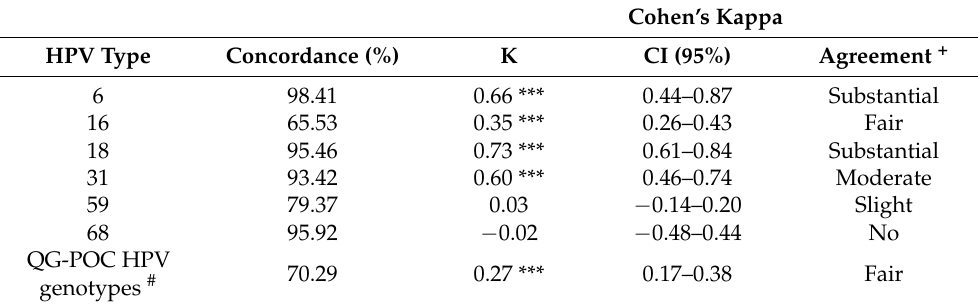
Table 4. Concordance between MPG and QG-POC assay for detected HPV